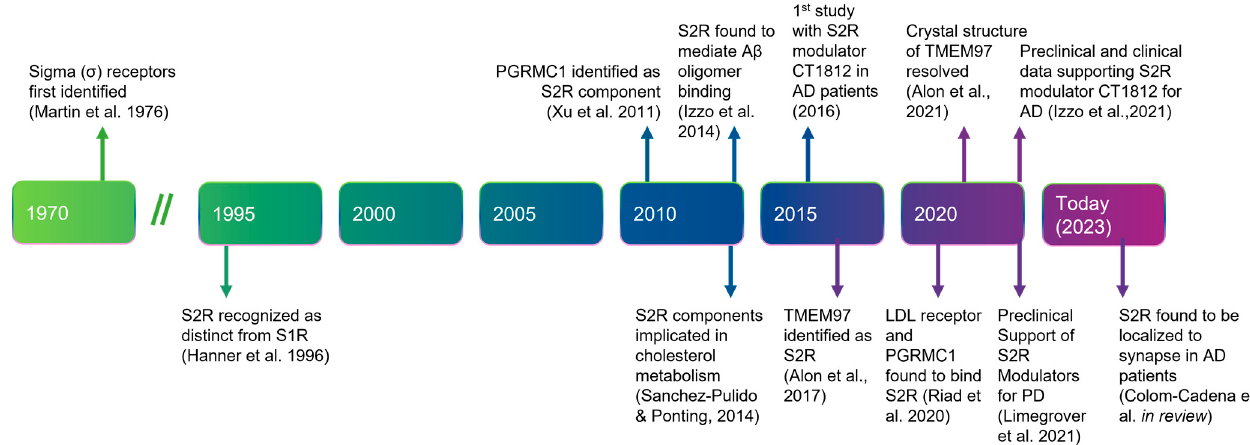
Figure 1. Timeline of the discovery and elucidation of S2R from inception to therapeutic modulation .